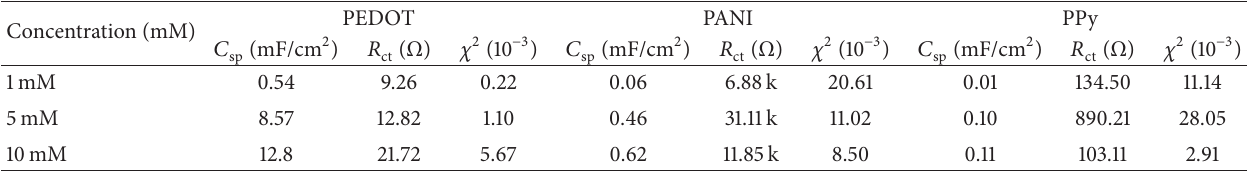
Table 3: Electrochemical properties obtained from fitting data of Nyquist